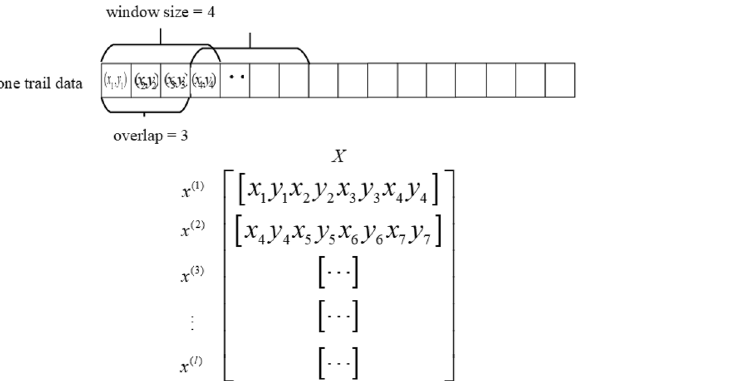
Figure 11. Trajectory data framing